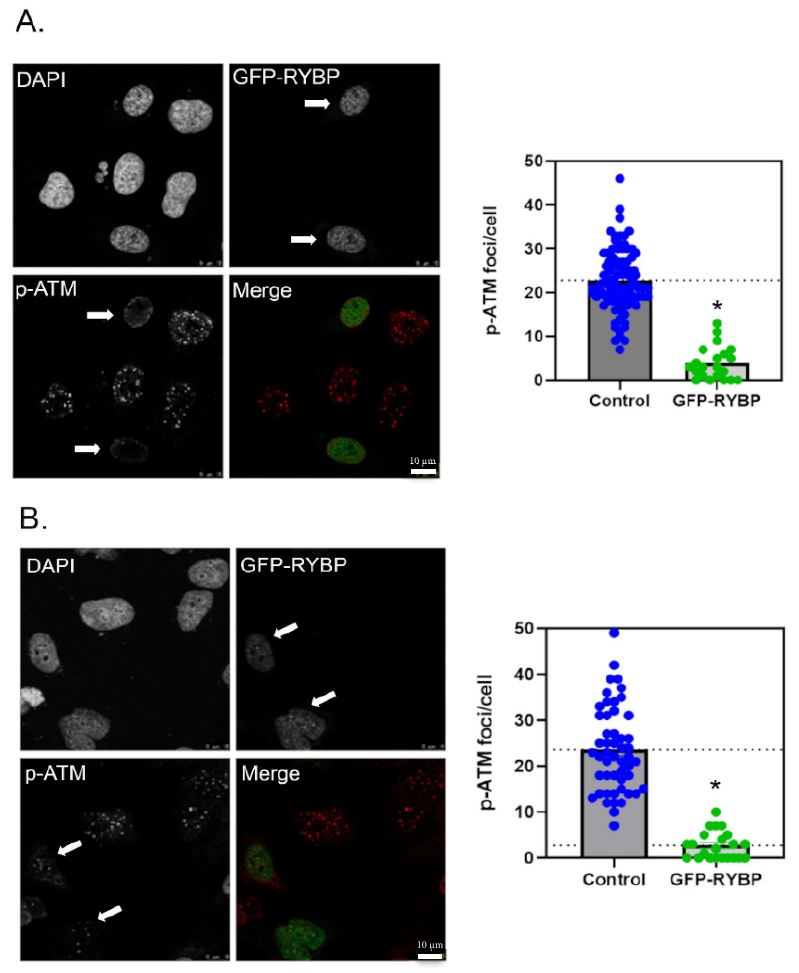
Figure 1. Effect of RYBP expression on phosphorylation of ATM after DNA damage. ( A ). Left; cells transfected with GFP ‐ RYBP and treated with calicheamicin (50 pM, 1 h). Arrows indicate that cells expressing GFP ‐ RYBP have less p ‐ ATM foci. Right; quantification of p ‐ ATM foci per nucleus (at least 50 nuclei from 3 independent experiments) in control and RYBP ‐ expressing cells. ( B ). Left; cells transfected with GFP ‐ RYBP and treated with camptothecin (10 μ m, 1 h). Arrows indicate that cells expressing GFP ‐ RYBP have less p ‐ ATM foci. Right; quantification of p ‐ ATM foci per nucleus (at least 50 nuclei from 3 independent experiments) in control and RYBP ‐ expressing cells. * p < 0.5 (Stu ‐ dent’s t ‐ test). In the merged images, GFP ‐ RYBP (green) and p ‐ ATM (red). Scale bar is 10 μ m.